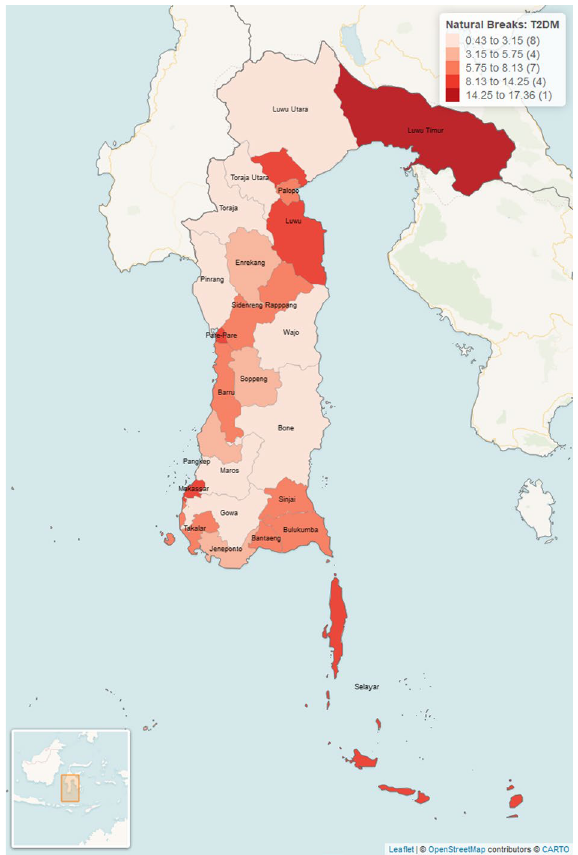
Figure 2. Prevalence rate of type 2 diabetes mellitus for the 2017–2018 period in South Sulawesi Province. The number in the parentheses indicated the number of districts/cities. This figure was generated by using R Basic version: 4.2.2 (https:// cran.r- proje ct. org/ bin/ windo ws/ base/) and R Studio Desktop version: 2022.07.2 + 576 (https:// posit. co/ downl oad/ rstud io- deskt op/) for windows operating system. We also utilized several packages to produce this figure such as sf package (https://r- spati al. github. io/ sf/), dplyr package (https:// github. com/ tidyv erse/ dplyr), rgdal package (http:// rgdal.r- forge.r- proje ct. org/), tmap package (https:// github. com/r- tmap/ tmap) and leaflet package (https:// rstud io. github. io/ leafl et/). The details of district/city covered in this figure are listed as follows: (0.43 to 3.15): Luwu Utara, Toraja Utara, Toraja, Pinrang, Wajo, Bone, Maros, Gowa (8 districts/cities). (3.15 to 5.75): Enrekang, Soppeng, Pangkep, Jeneponto (4 districts/cities). (5.75 to 8.13): Palopo, Sidenreng Rappang, Barru, Takalar, Bantaeng, Bulukumba, Sinjai (7 districts/cities). (8.13 to 14.25): Luwu, Pare- Pare, Makassar, Selayar (4 districts/cities). (14.25 to 17.36): Luwu Timur (1 districts/cities).